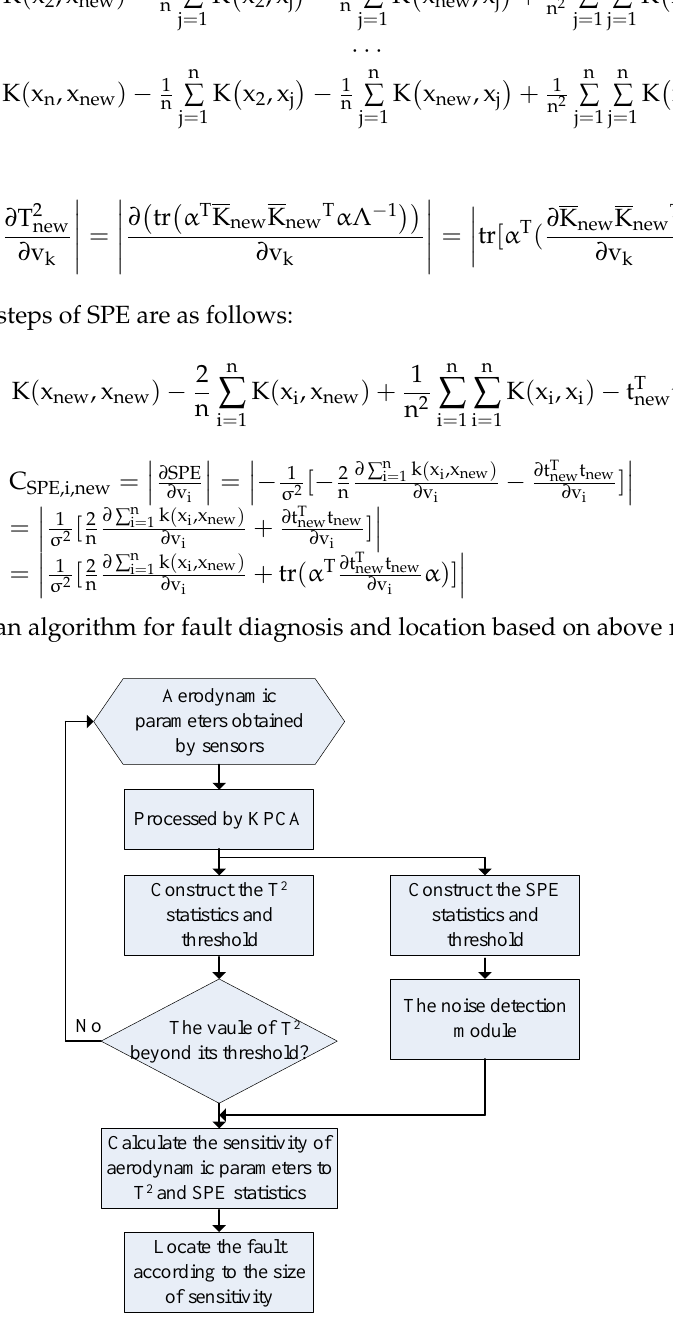
Figure 1. Process of fault diagnosis and location.